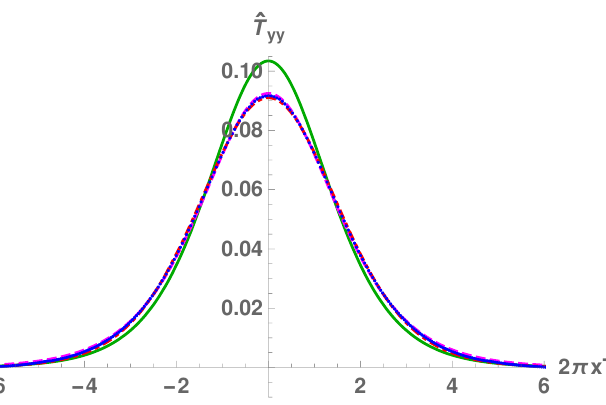
ˆ Figure 6 . Phenomenological fitting of the (normalized) T yy component of the energy-momentum tensor. The blue dots show the energy-momentum tensor extracted from the numerically con- structed geometry of [20]. The green curve is the prediction from the fit of figure 5, given in equation (3.15). The dashed magenta and dot-dashed red fits were obtained by using the former and latter formulas of equation (3.16),